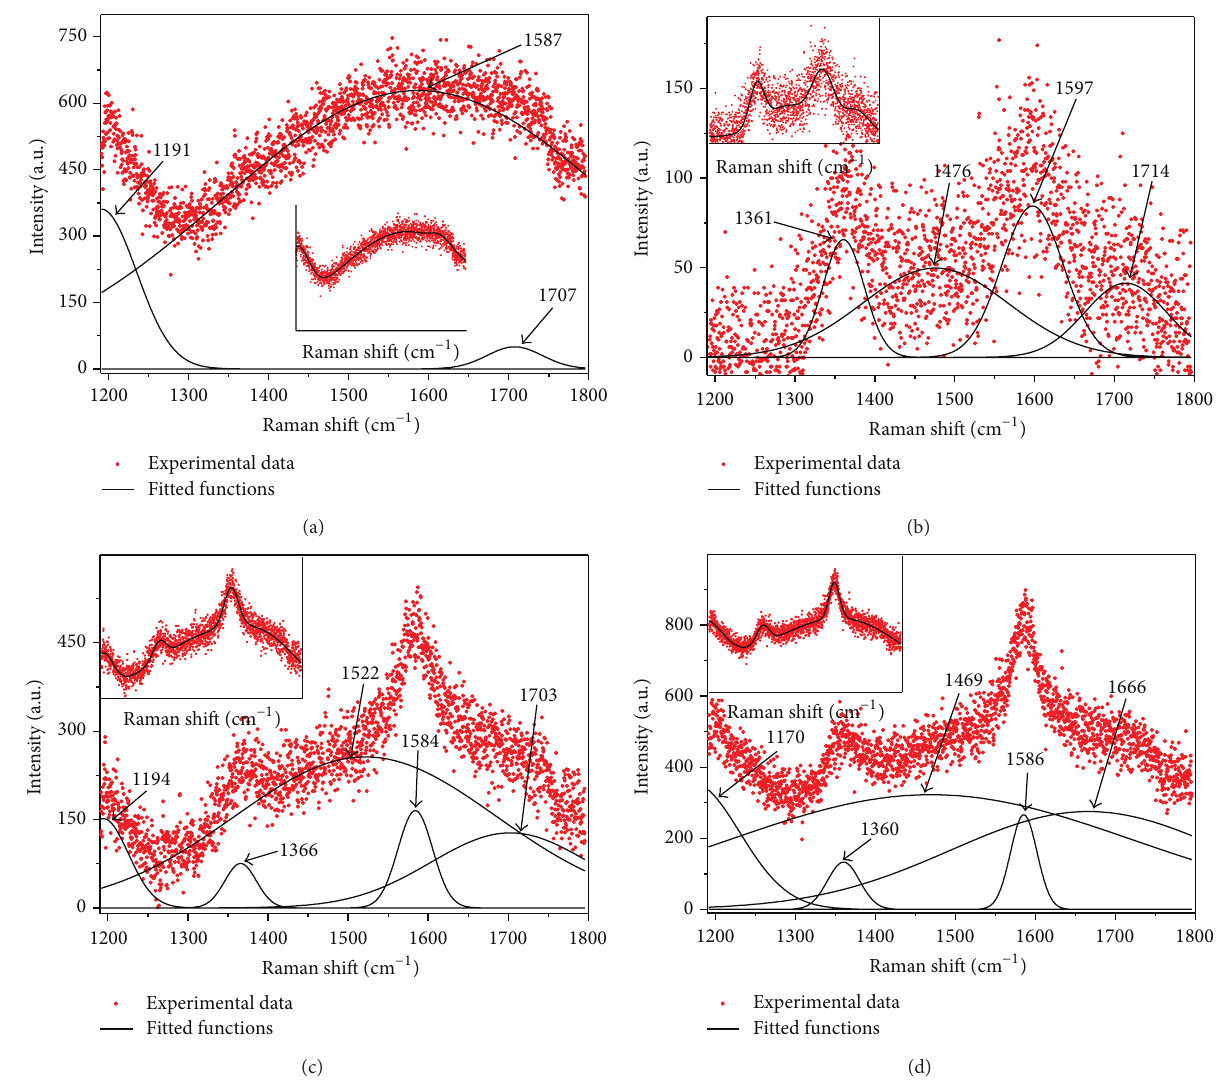
Figure 13: Raman spectra recorded for the Ni 2 Si/ n -SiC contacts with FL-Si after different thermal treatment: (a) as-deposited; (b) 600 ∘ C/15min; (c) 950 ∘ C/3min; (d) 1050 ∘ C/3min.